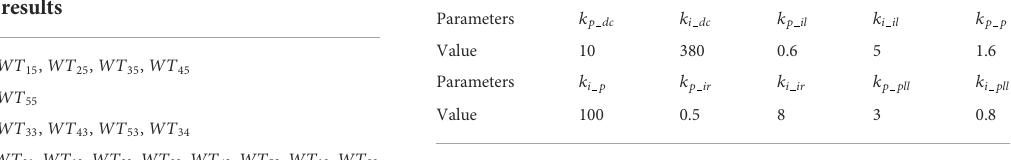
TABLE 5 The clustering results for DFIG-based wind farm by WFCM.